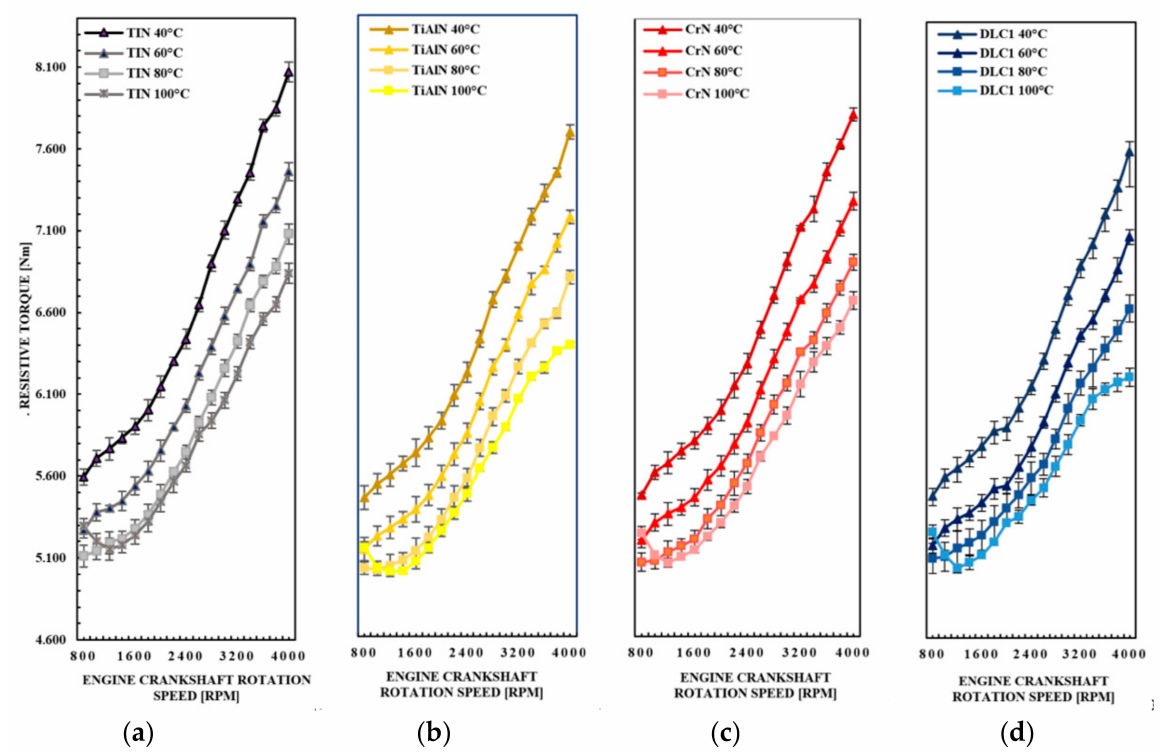
Figure 7. The waveforms of the torque of the resistance to motion of the motor for the ( a ) TiN, ( b ) TiAl, ( c ) CrN and ( d ) DLC1 coating in the range from 800 to 4000